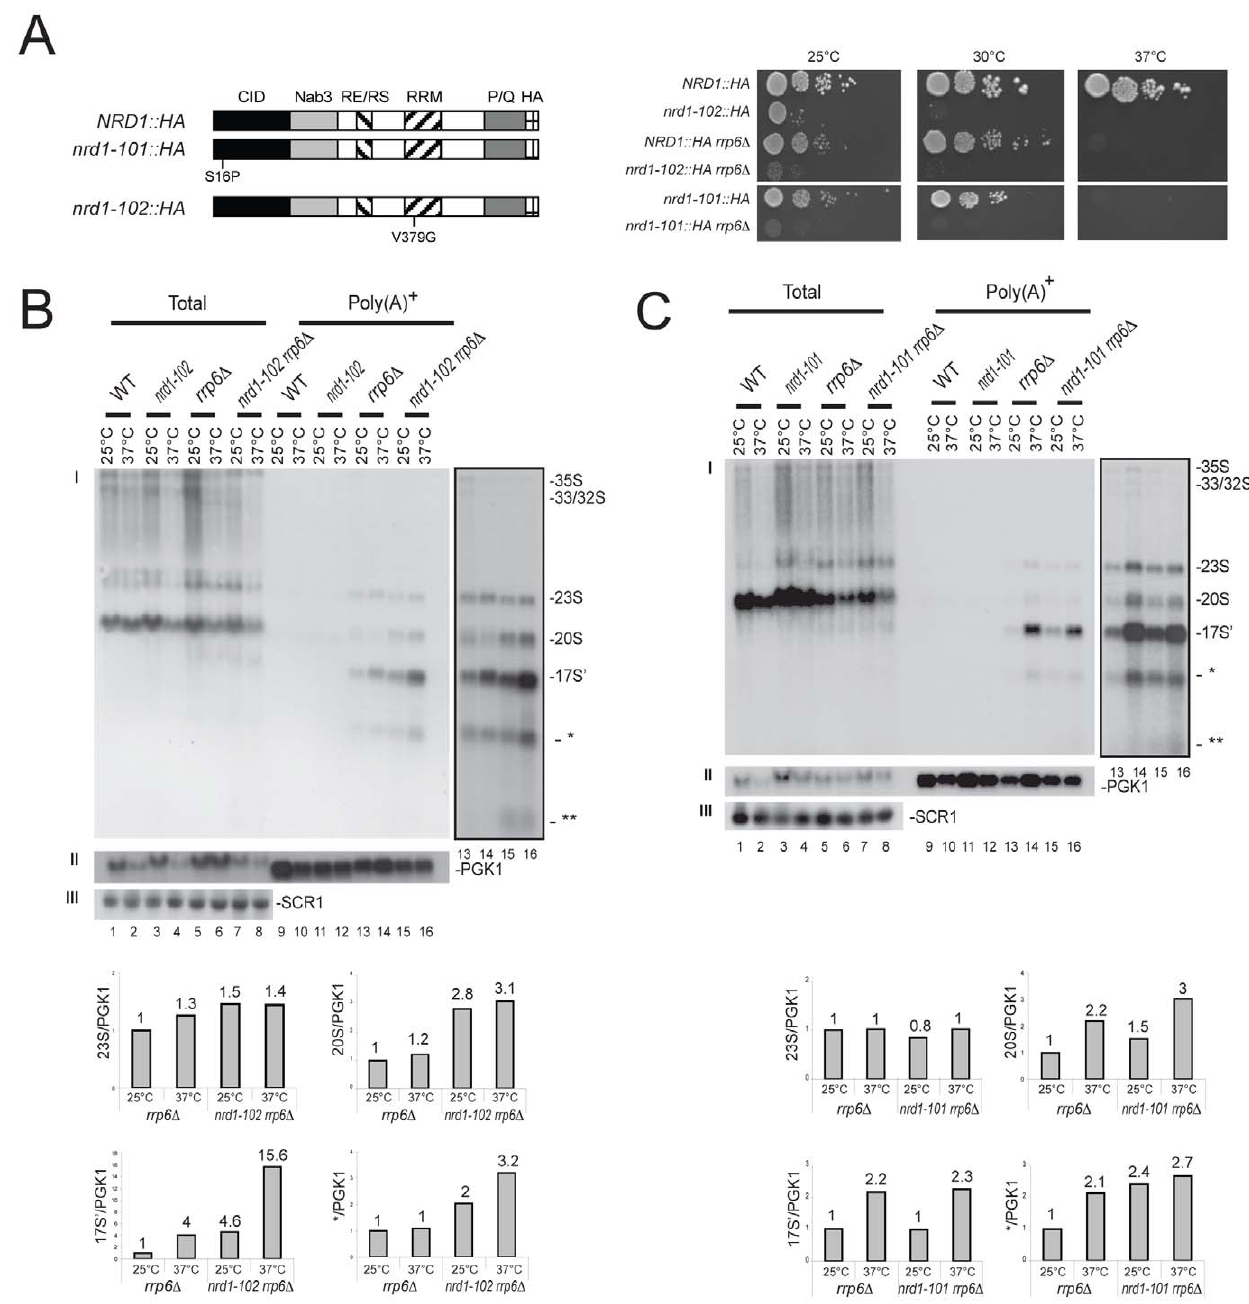
Figure 1. Involvement of the RRM and CID domains of Nrd1 in nucleolar surveillance. A , (left) Domain mapping of Nrd1. All three nrd1 alleles used in this work (provided by Prof. Jeff Corden, Johns Hopkins University School of Medicine) are HA-epitope tagged at the carboxyl terminal end of the protein, which allowed us to establish that neither mutation affects protein stability (see Fig S2B and C). Nrd1 consists of an amino terminal RNA Pol II CTD interacting domain (CID), followed by a Nab3-interacting domain (Nab3), a central RE/RS-rich domain (RE/RS), an RNA binding domain (RRM), and a carboxyl terminal P/Q-rich-domain. The amino acid substitutions responsible for the thermosensitive phenotypes for growth in the conditional alleles, nrd1-101 and nrd1-102, are indicated. (right) Ten-fold serial dilutions of yeast cultures. Cells were grown on solid rich medium at the indicated temperatures for 2 d (30 u C and 37 u C) or 3 d (25 u C). The Nrd1-HA-tagged wild-type control construct was fully functional. B, Analysis of the RRM mutation. (top) Northern-blot analysis of total and purified poly(A) + RNAs in different mutant background at the indicated temperatures. Poly(A) + RNA was purified on poly-dT-coated magnetic beads (see [6]). Total RNA and poly(A) + RNAs were loaded in a 1:50 ratio, separated on 1.2% agarose/6% formaldehyde gel, transferred to nylon membranes and hybridized. Cells were grown to mid-log phase at 25 u C and then transferred to the non-permissive temperature for 2 h. The probe used to detect the pre-rRNAs was LD471 (panel I, see Fig S3A). Total RNA was normalized to SCR1. Poly(A) + RNA was normalized to the PGK1 mRNA. (bottom) Phosphor Imager quantitation. Histograms represent the relative distribution of specific RNA normalized to the PGK1 mRNA in different mutant background at different temperatures. C, Analysis of the CID mutation. Legend as in panel B. See also Fig S2.